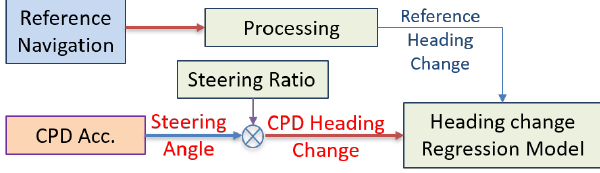
Figure 3. CPD Heading change errors modeling using